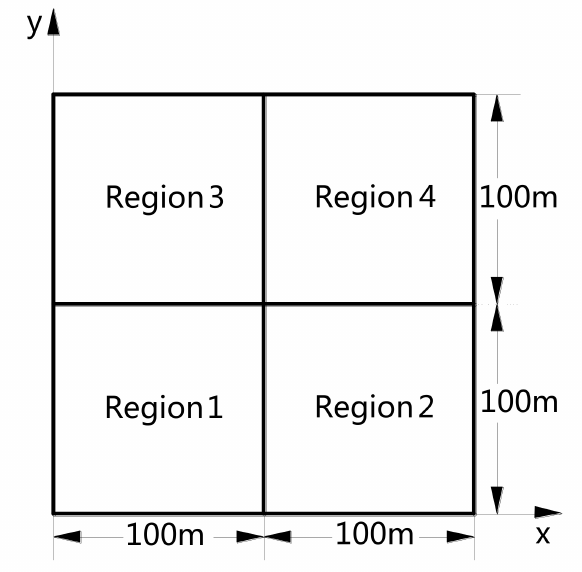
Figure 22. Sketch of the symmetric 2D Riemann problem.